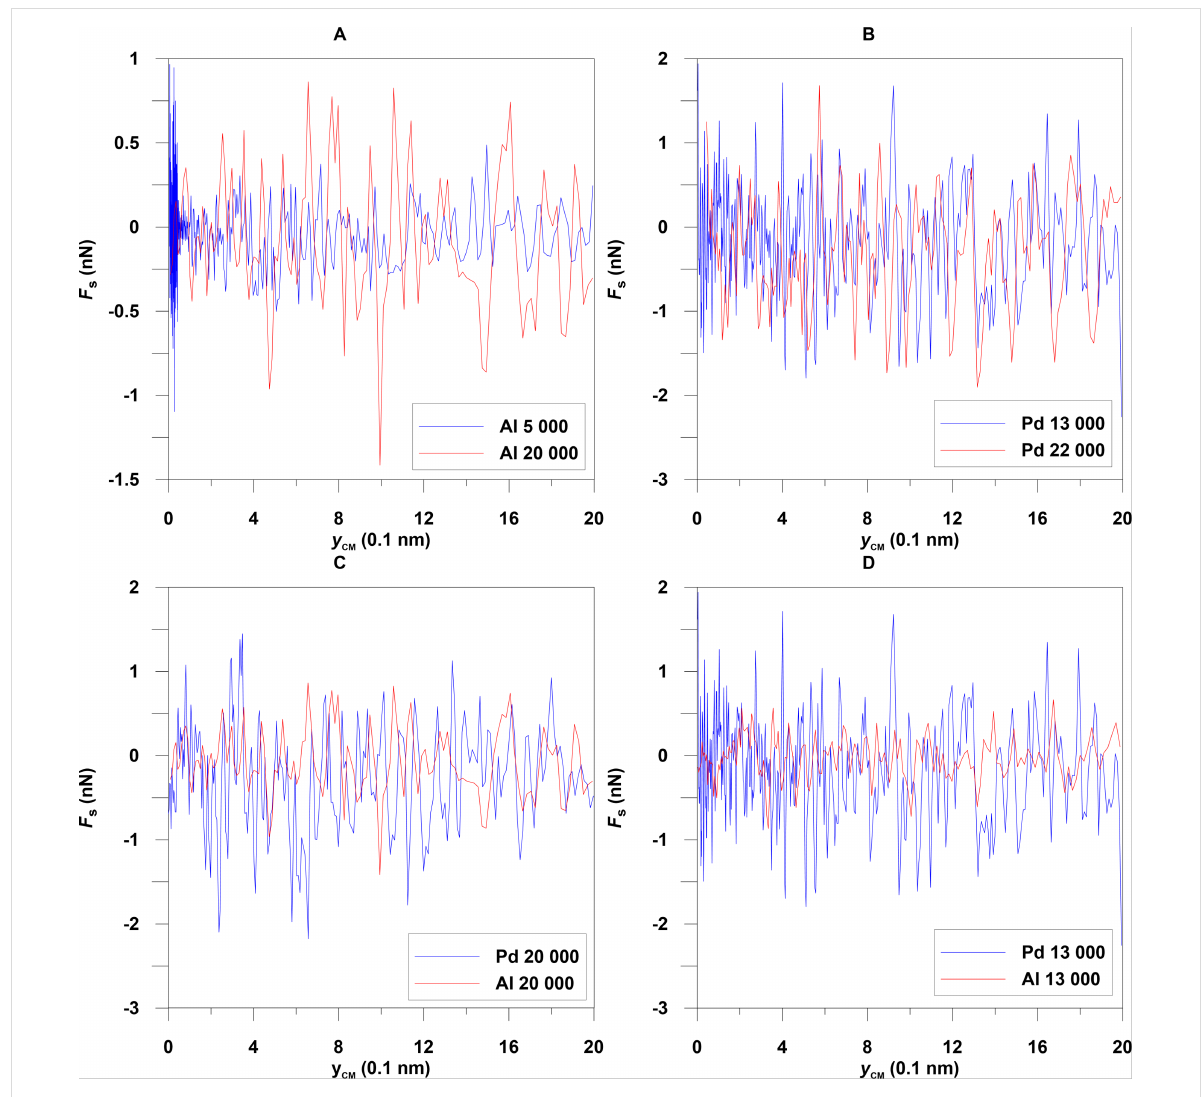
Figure 3: Substrate force as a function of the lateral position of the center of mass of the nanoparticles: (A) Al with 5000 and 20000 atoms, (B) Pd with 13000 and 22000 atoms, (C) Al and Pd with 20000 atoms, (D) Al and Pd with 13000 atoms at a temperature of 300 K.